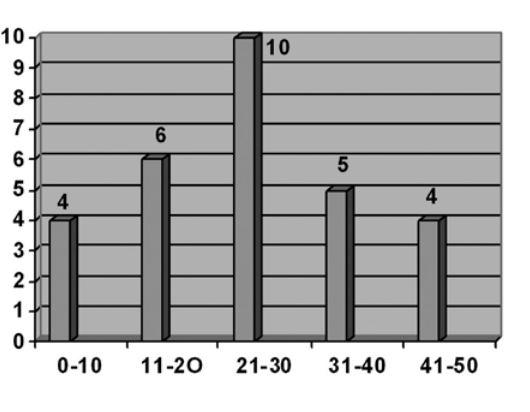
Figure 4. Distribution of human bite injuries according